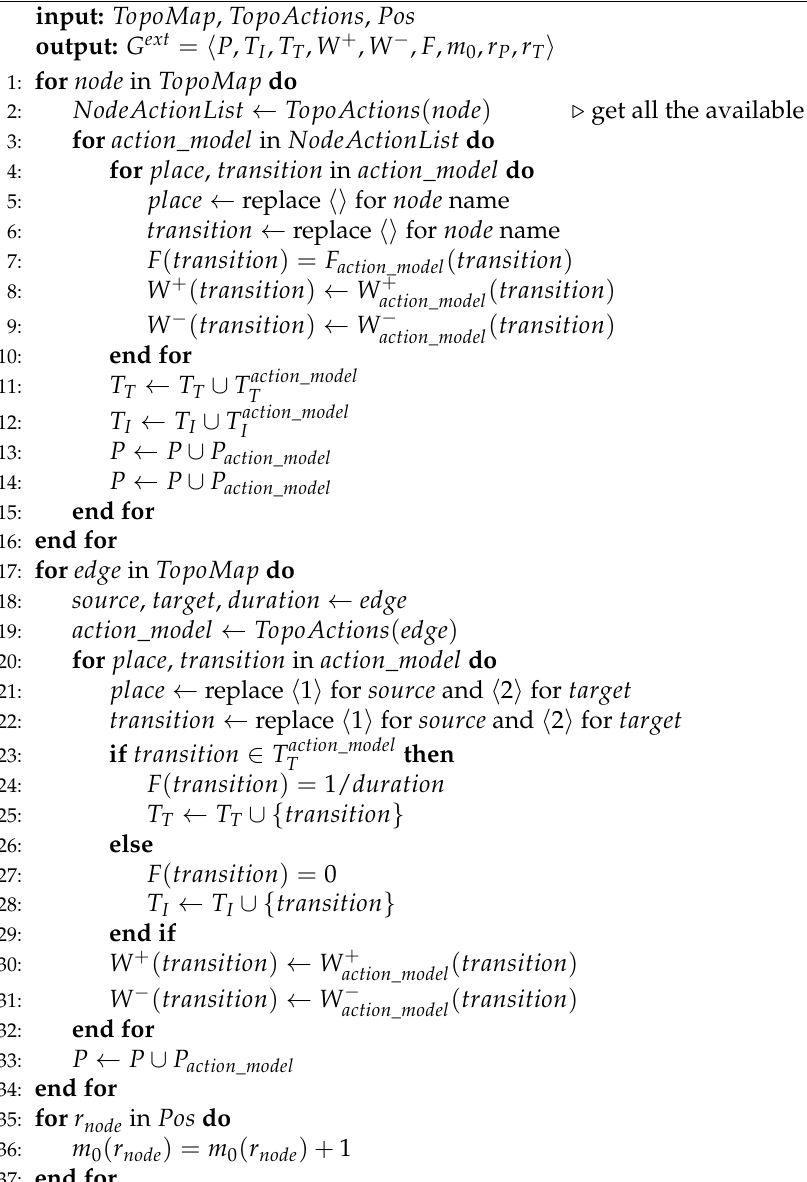
Algorithm 1 Algorithm that builds an extended GSPNR from action models and a topolog- ical